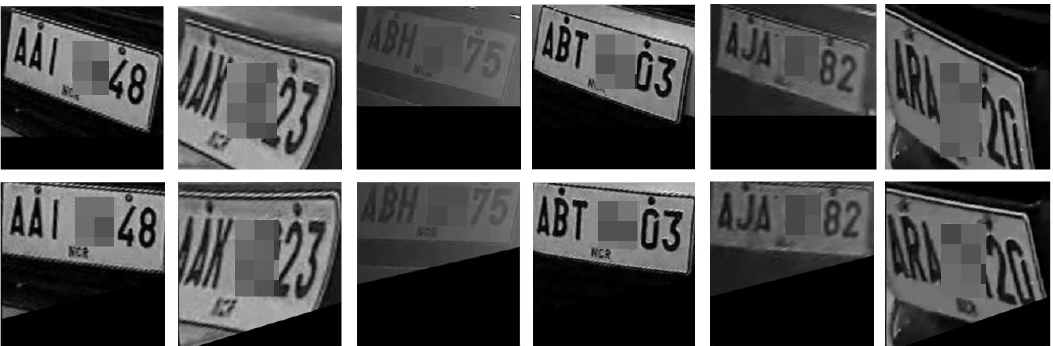
Figure 4. Plate images before the transformation (top row) and the corresponding rectified images (bottom row) by using the four-corner predictions from the hybrid model. Parts of the plates are blurred for privacy reasons.